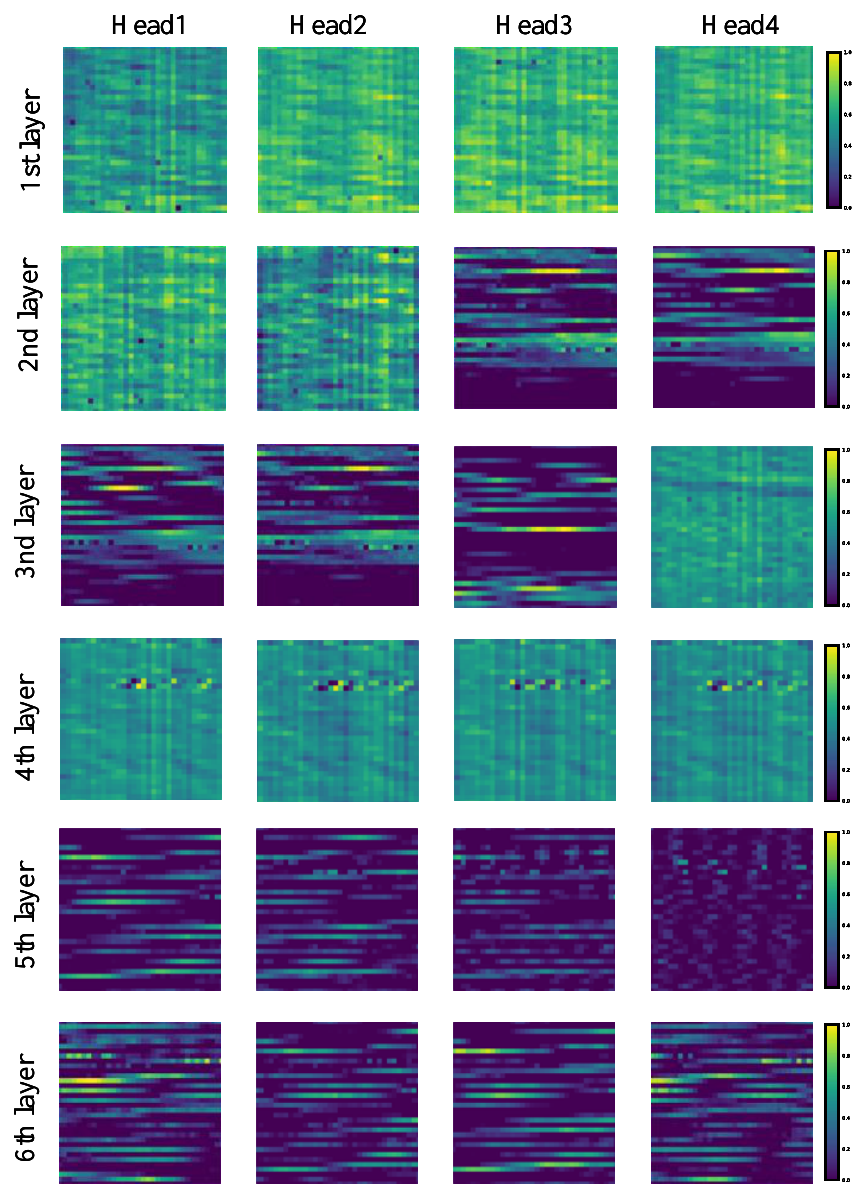
Figure 15. Visualization of Q and K feature matrix in the multihead self-attention